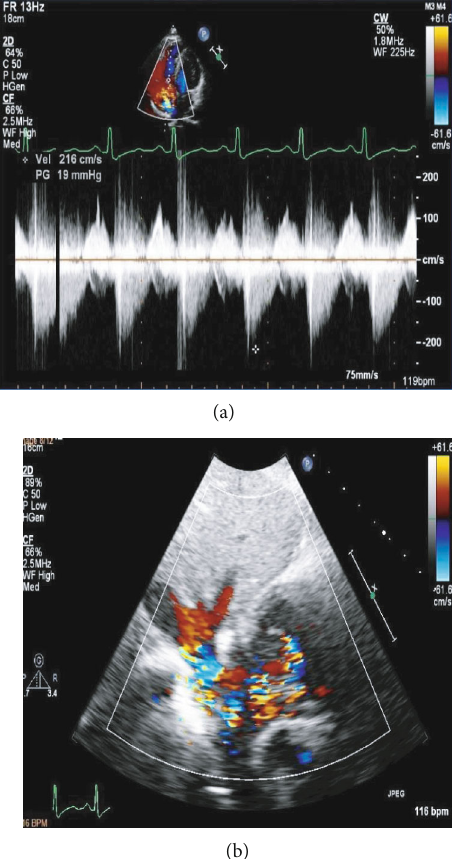
Figure 3: (a) Continuous wave Doppler through the tricuspid valve in 4-chamber view showing an early peaking triangular tricuspid regurgitation velocity. (b) A subcostal view showing hepatic vein systolic fl ow reversal due to severe tricuspid valve regurgitation on colour fl ow